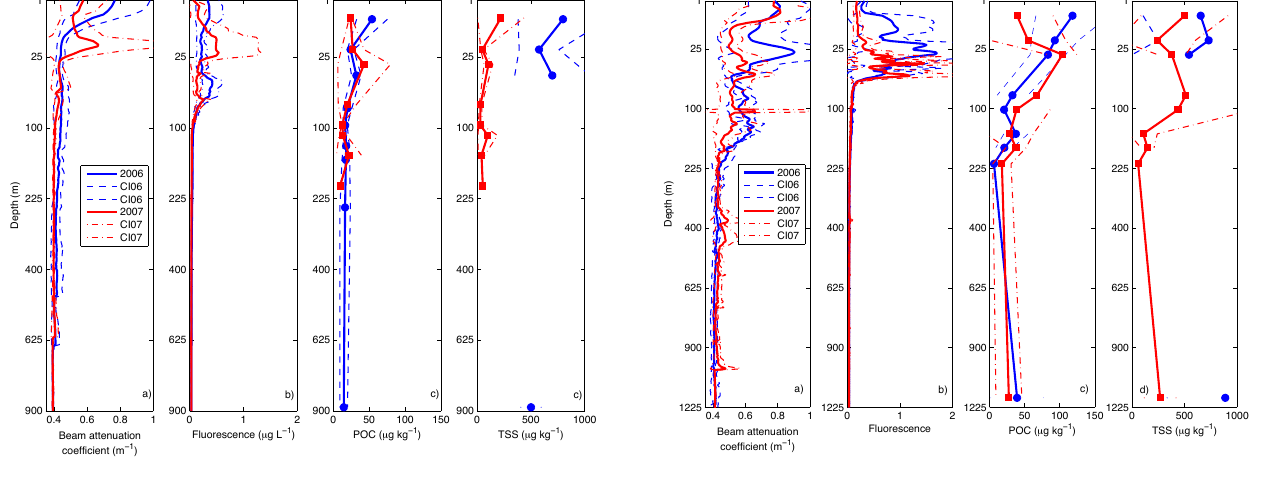
Fig. 2. Average profiles of (a) beam attenuation coefficient, (b) flu- orescence, (c) POC, and (d) TSS in the eastern Beaufort shelf region for 2006 (blue lines) and 2007 (red lines). The vertical axis is non- linear (square root) to emphasize the near-surface features. Only the upper 900m are shown because there were no attenuation fea- tures or bottle samples below this depth. The red and blue dashed lines represent the 95% confidence intervals for 2006 and 2007, re- spectively. For beam attenuation coefficient only, the 5m centred running mean is plotted to smooth the data. The blue circles and red squares represent the average sampling depth for POC and TSS in 2006 and 2007, respectively.